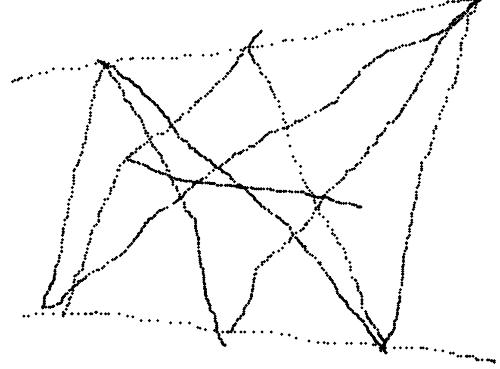
Figure 4. Strokes used as input for the construction depicted in Figure 5.